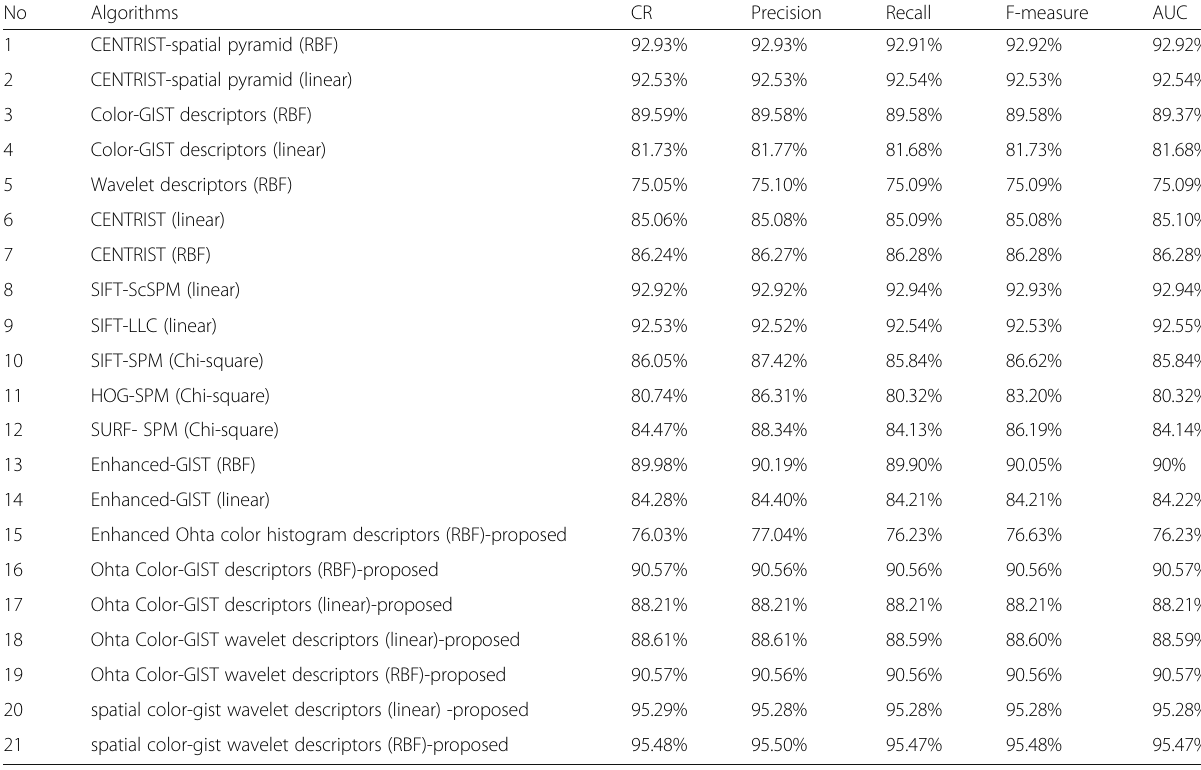
Table 1 Scene categorization performance on the Indian institute of technology madras-scene classification image database two